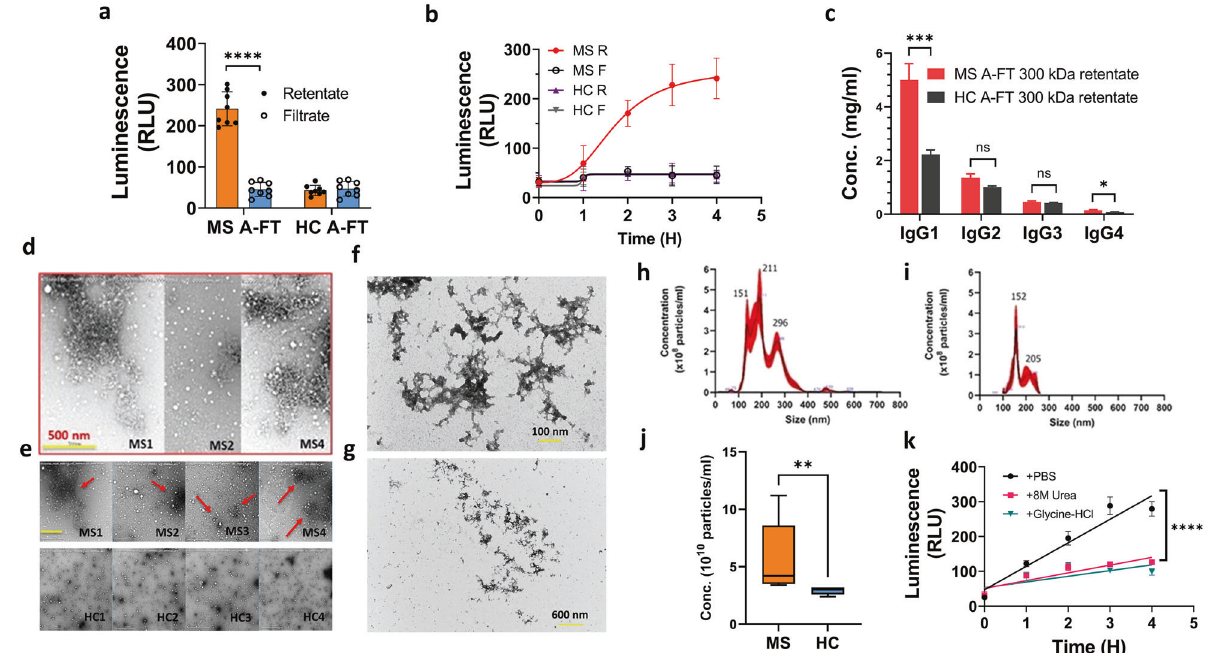
Fig. 6 MS plasma IgG antibodies form IgG aggregates which were retained in the retentates after 300 kDa fi ltration. a Only the 300 kDa retentates but not the fi ltrates of MS A-FT drove apoptosis in neurons ( p < 0.0001, n = 8 each). b . Time-dependent apoptosis is shown by 300 kDa retentates of MS A-FT (R Retentate; F Filtrate). c Human IgG subclass ELISA shows signi fi cantly higher levels of IgG1 in MS 300 kDa retentates compared to HC (MANOVA p < 0.0001, n = 8 each). d Close-up views of TEM images demonstrating the IgG aggregates in the 300 kDa retentates from three individual MS A-FT. e TEM images showed that only MS samples (top panel) contained the IgG aggregates (red arrows); in HC A-FT 300 kDa retentates the IgG aggregates were essentially absent (lower panel). Scale bar: 500 nm. Uranyl acetate was used for staining. f , g TEM images of IgG aggregates in MS A-FT stained with uranyl formate at high ( f ) and low ( g ) magni fi cation. Scale bar: 100 nm ( f ), and 600 nm ( g ). h – j Nanoparticle Tracking Analysis (NTA) demonstrates that MS A-FT retentates ( h ) contained large particles (>100 nm) compared to HC A-FT ( i ). j Summary of NTA data showing that MS A-FT 300 kDa retentates contained twice the amounts of particles (> 100 nm) compared to HC (** p < 0.01, n = 4 each). k Disruption of the IgG aggregates abolished MS A-FT-induced apoptosis. Incubation with 8 M urea or 0.2 M Glycine-HCl, pH 2.8 abolished MS A-FT-induced neuronal apoptosis in a time-dependent manner. Pooled MS A-FT ( n = 8) were incubated with 8 M urea or 0.2 M Glycine-HCl (1:3) at 37 °C for 1 h, followed by the collection of the 300 kDa retentates after 300 kDa and apoptotic